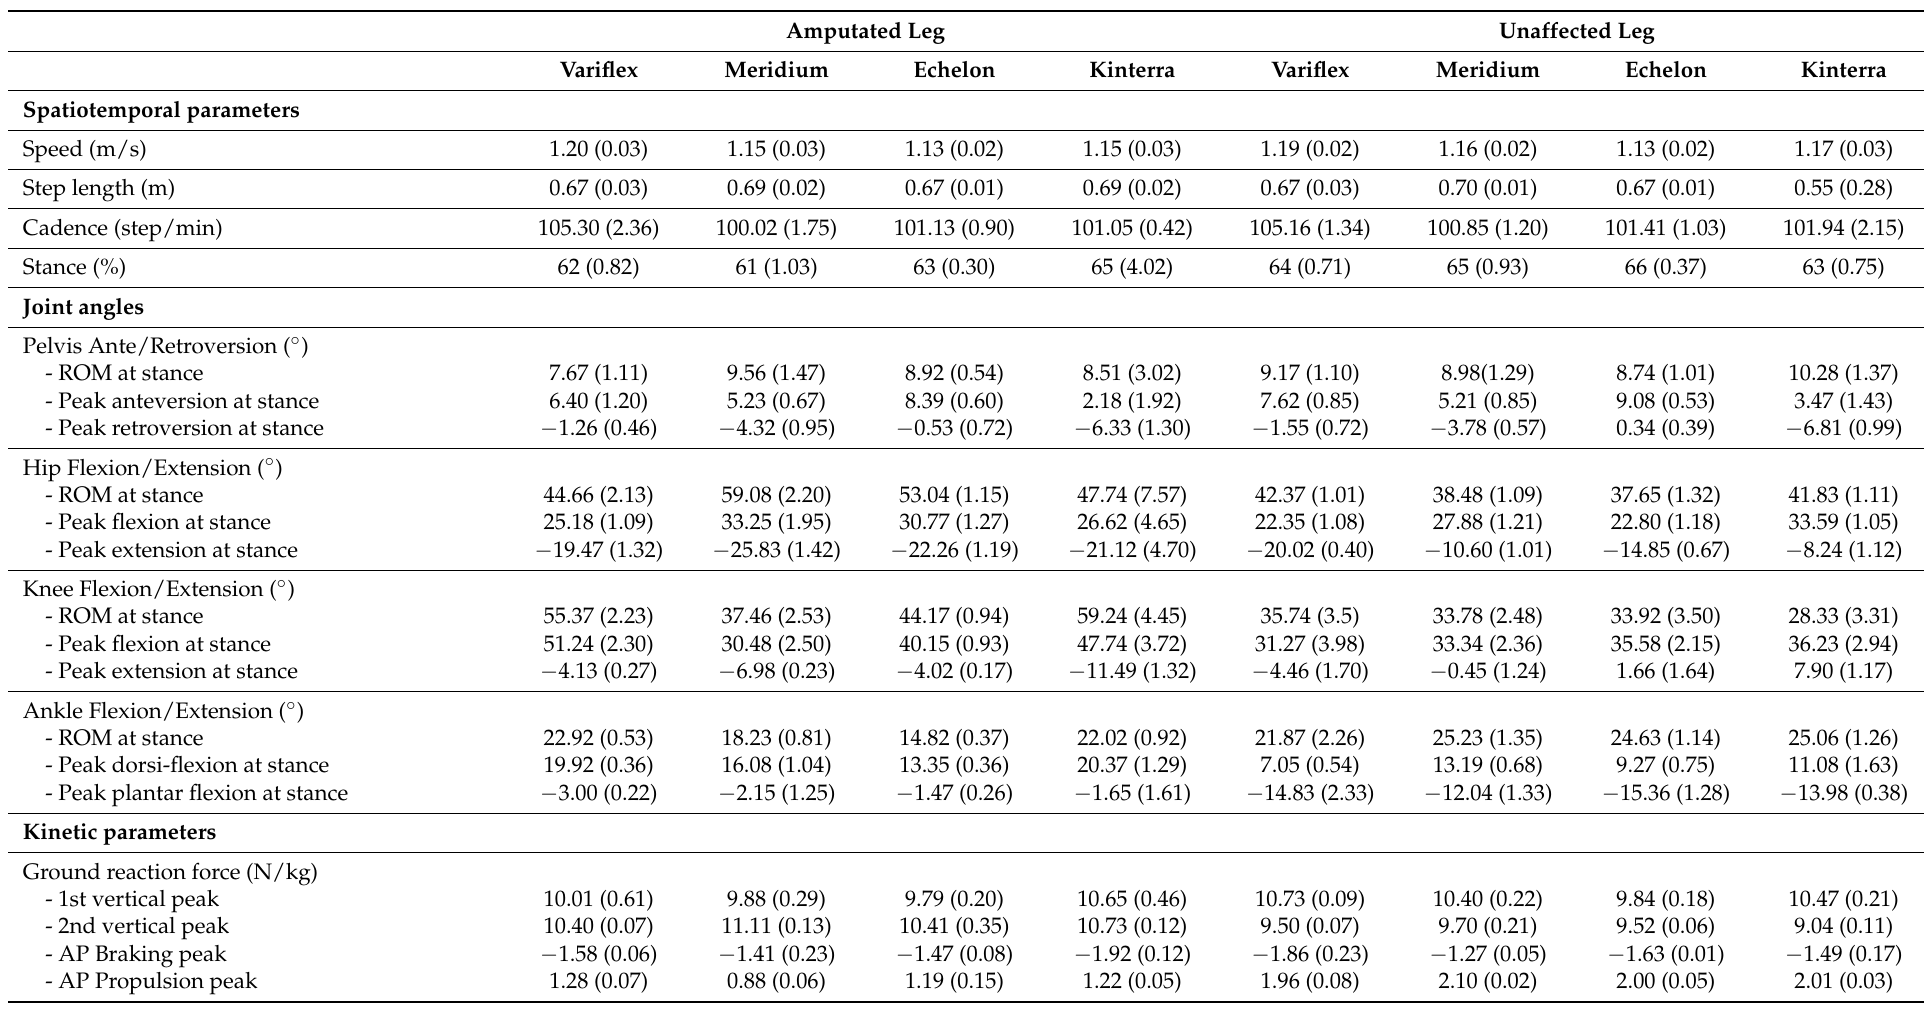
Table 2. Kinematic and kinetic outcomes during the four conditions. Values are expressed as mean